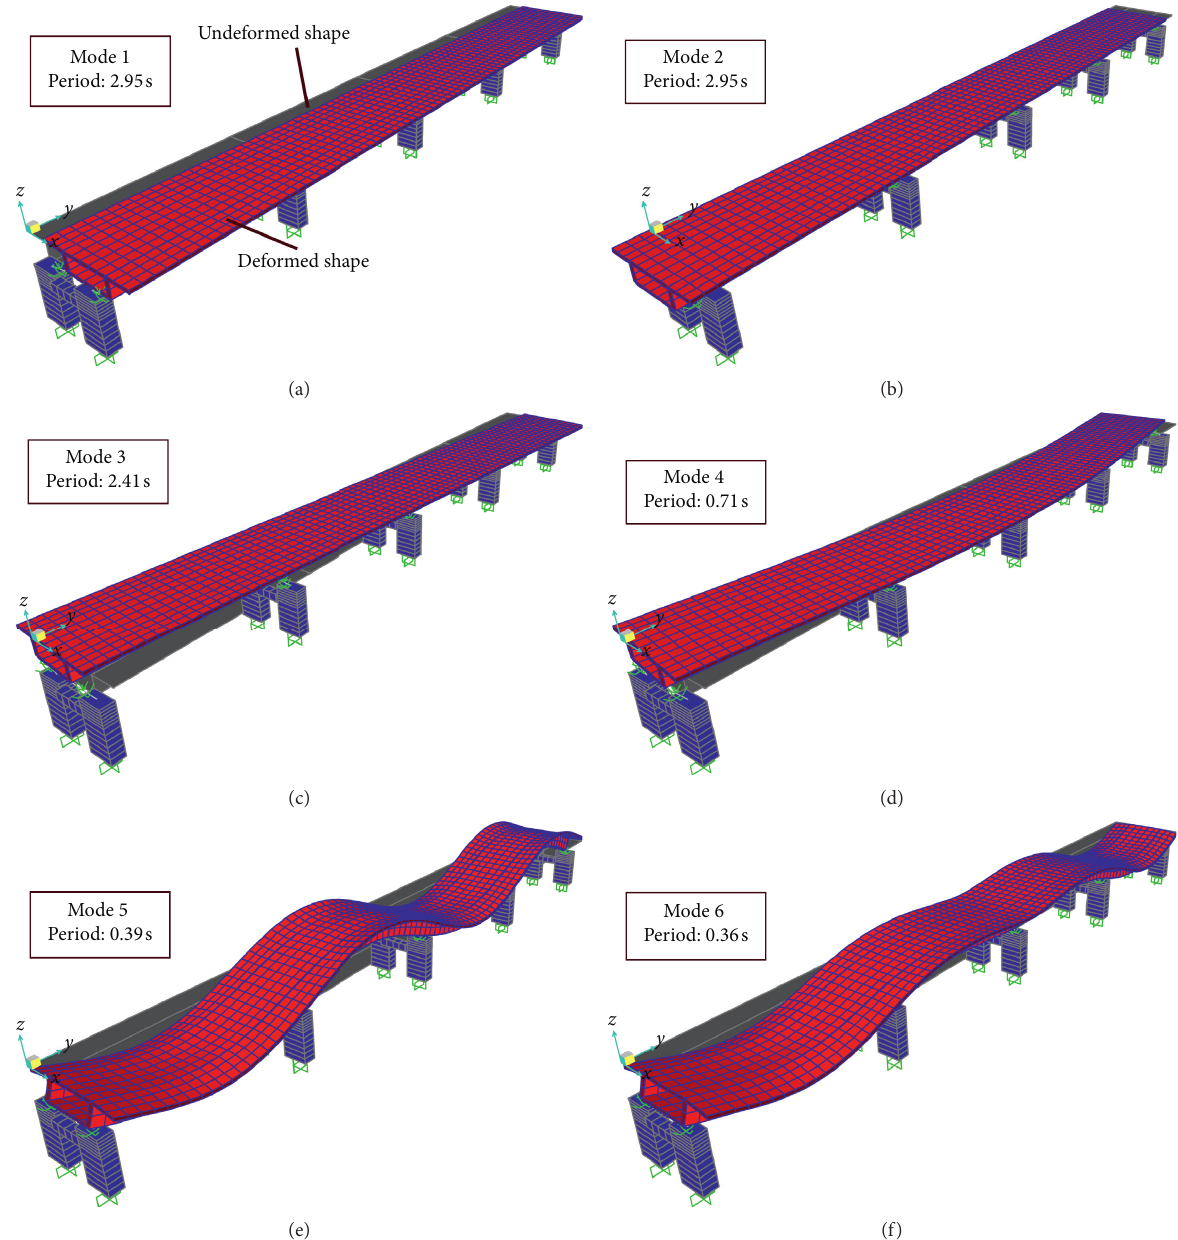
Figure 10: Modal periods and mode shapes when R �